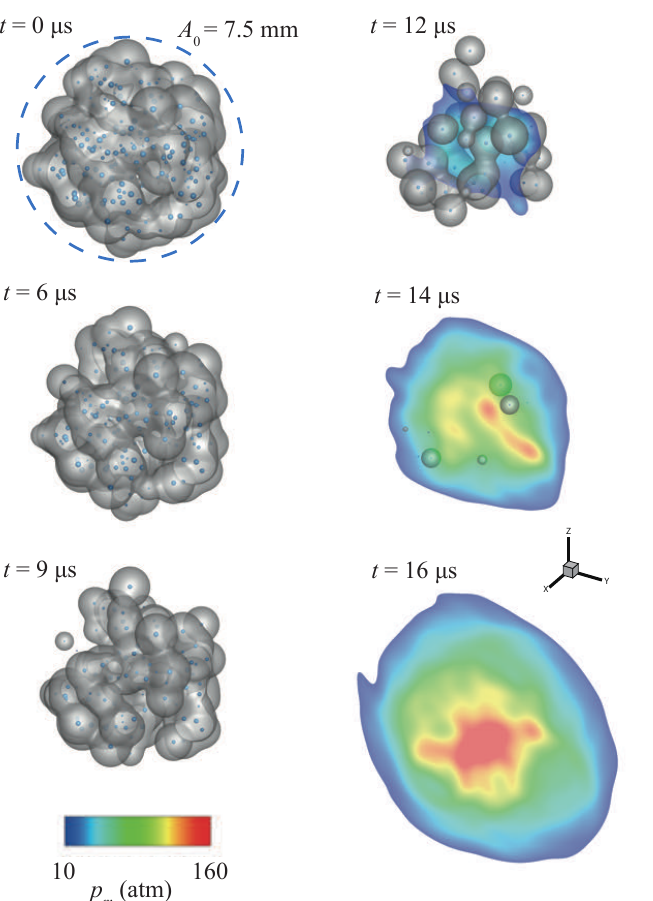
Figure 14. The snapshots of the collapsing process of a bubble cloud with N 0 = 200 vapor bubbles (at t = 0 µ s, 6 µ s, 9 µ s, 12 µ s, 14 µ s, and 16 µ s). The distribution of the vapor bubbles is visualized both by the iso-surfaces of the volume fraction α g = 0.002 ( α l = 0.998) and the Lagrangian spherical particles of the radius R b . Slices of the high pressure area (higher than 10 atm) at the center of the bubble cloud are also plotted, which indicate the cloud collapse induced violent